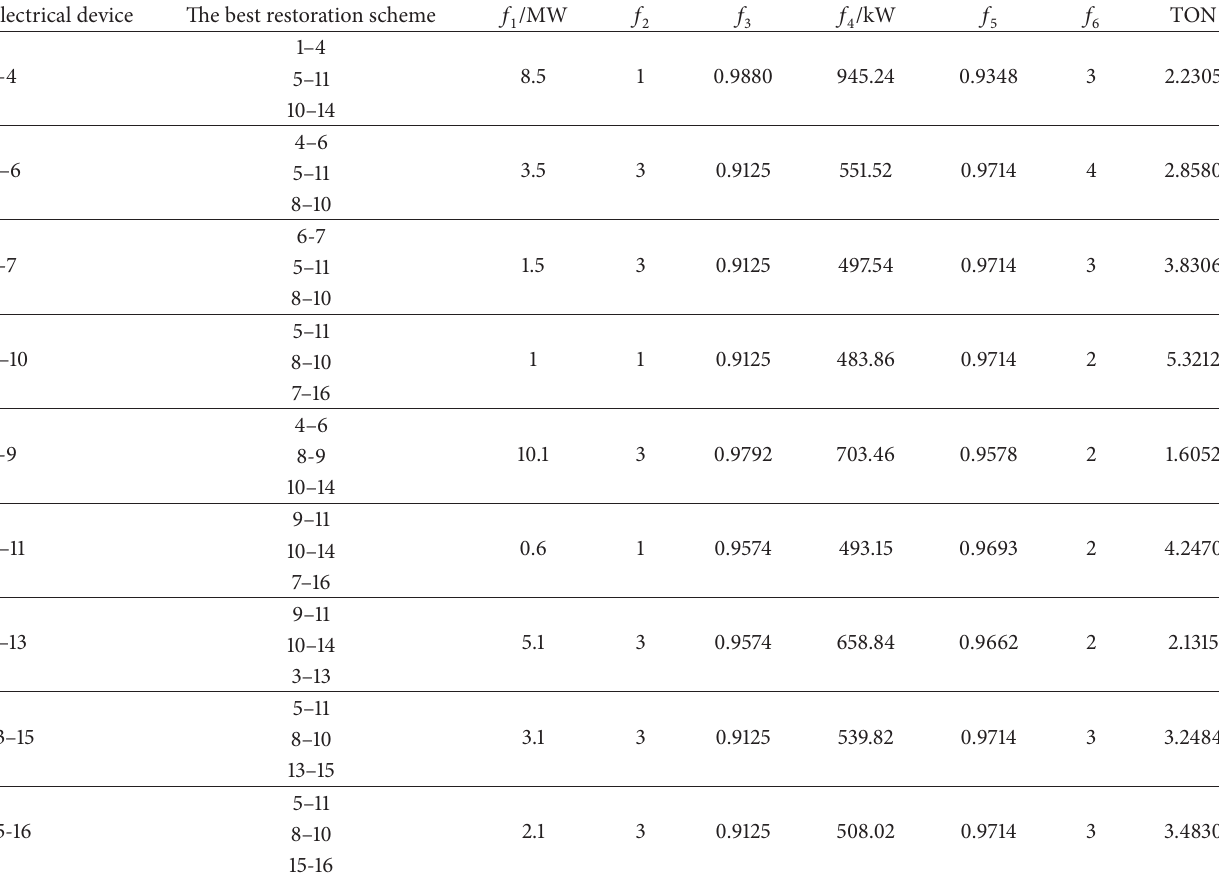
Table 8: The electrical devices of the first